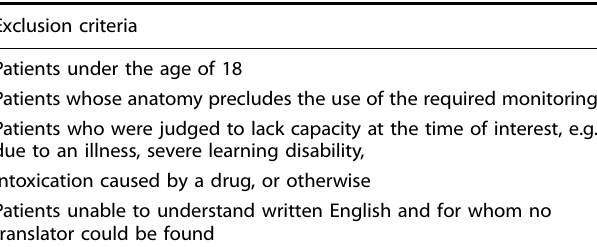
Table 4. Participant exclusion criteria.